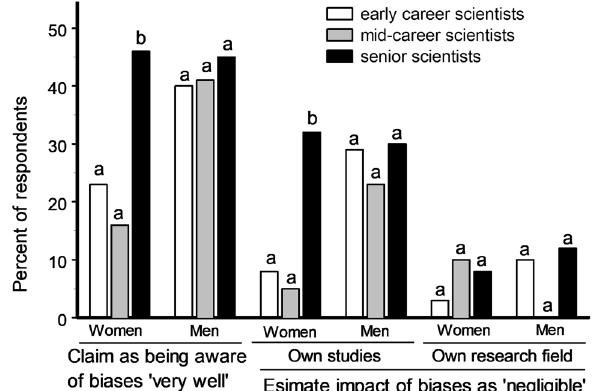
Figure 4. Self-estimates of the awareness about biases and of their impact on one’s own studies and on other studies in one’s own research field in female and male scientists in relation to the stages of their research careers, as reported by (women/men) 70/50 early career, 19/27 mid-career and 26/65 senior scientists. Bars marked with different letters differ from each other at P < 0.05 within each group ( χ 2 test).